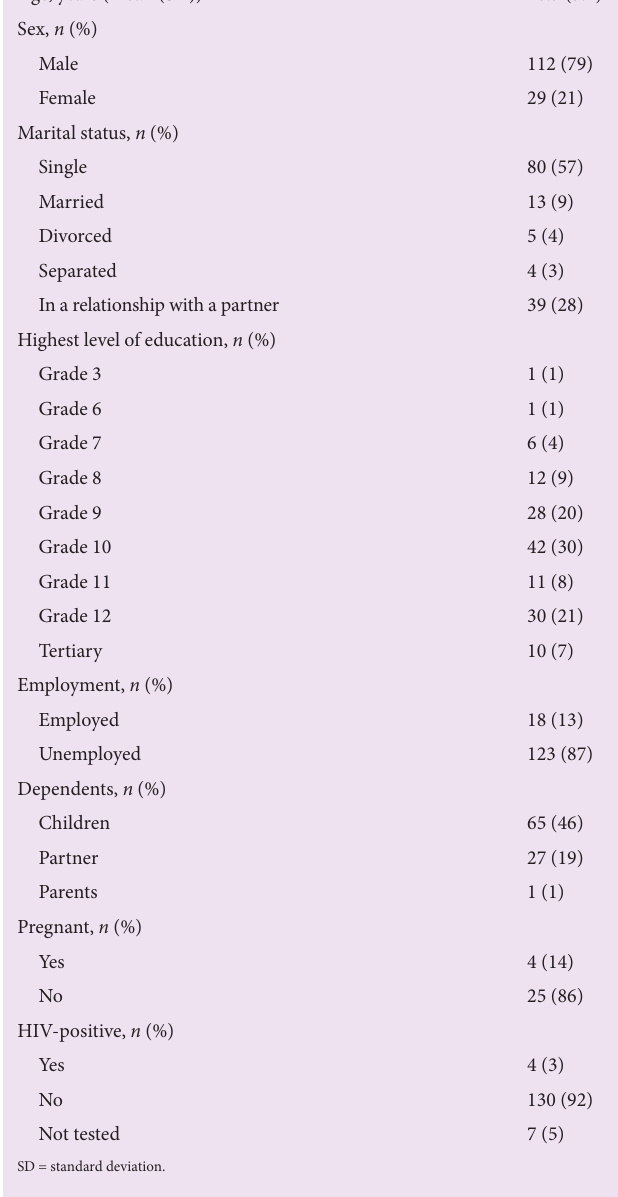
Table 1. Demographic data of the sample ( N